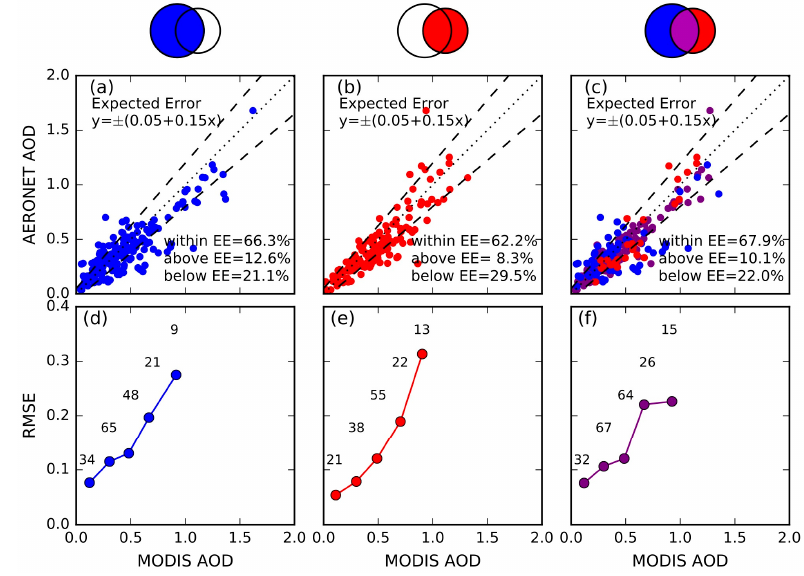
Figure 7. ( a – c ) are scatter plots of AERONET 0.55 µ m AOD observations versus retrievals from MODIS (MxD04 and/or CW) for the 6 monthly cases. Sampling method is same as in Figure 6. 1:1 lines and expected error (EE) envelopes (+(0.05 + 15%), − (0.05 + 15%), symmetric) are plotted as dotted and dashed lines. ( d – f ) are root mean square error (RMSE) as a function of MODIS AOD in the 0.2 interval. Numbers above the averaged dot show how many AERONET-MODIS collocations are available to calculate RMSE.